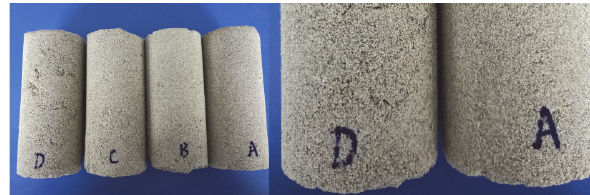
Figure 9: Surface erosion conditions of specimens under various curing humidity conditions.